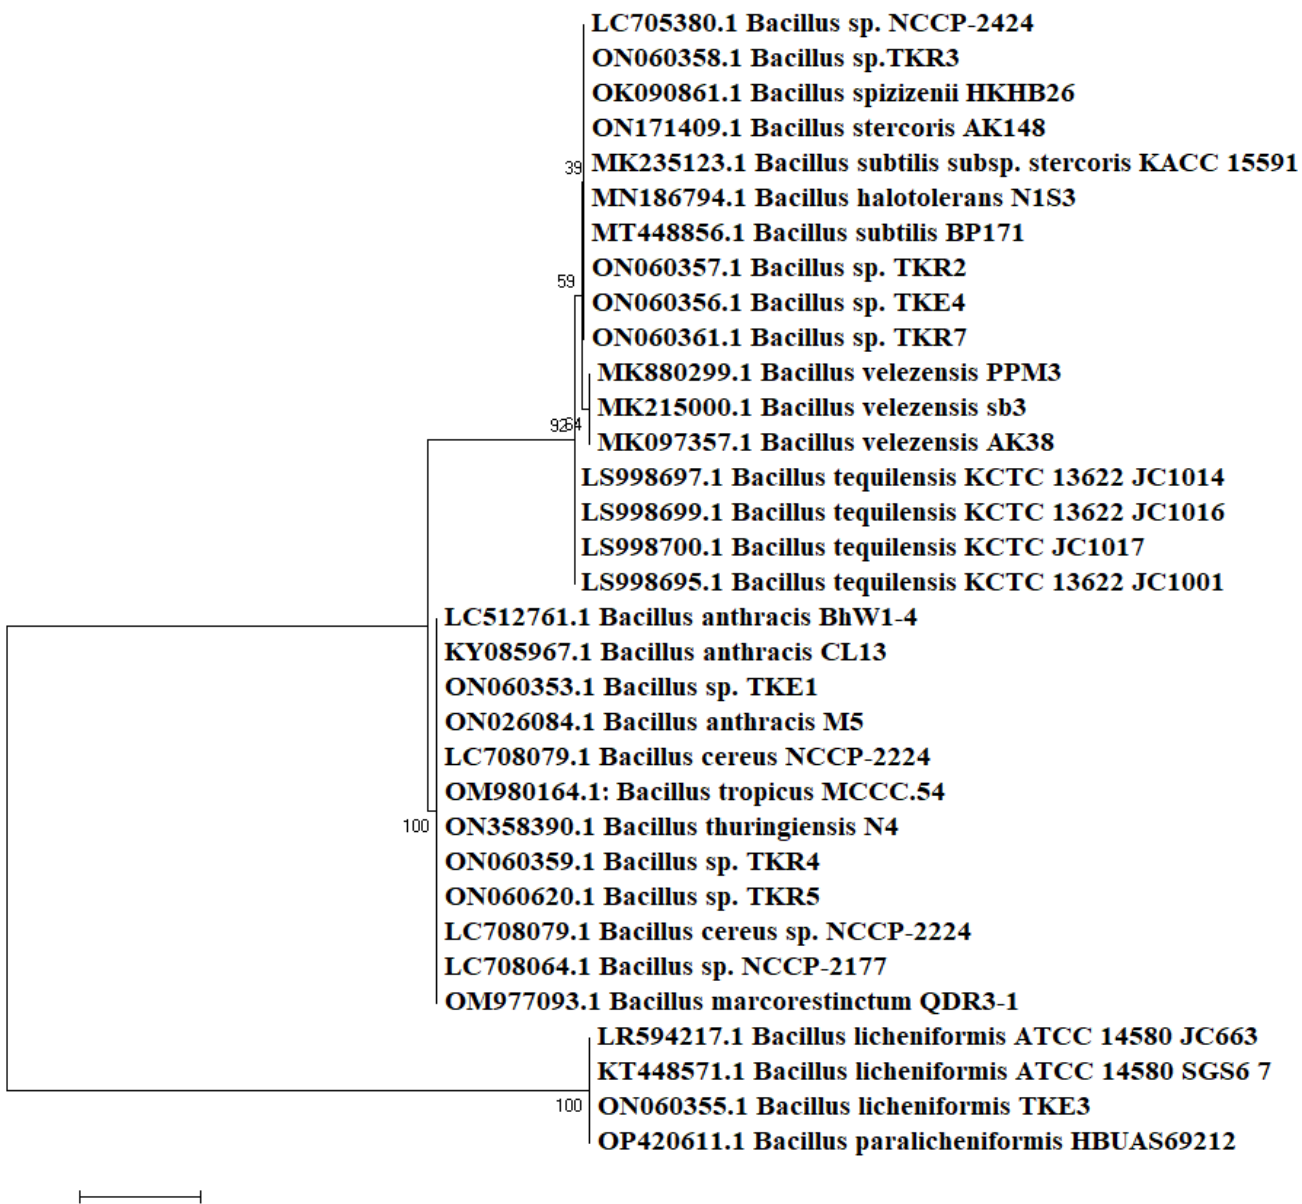
Figure 2. ( A ) Frequency of enzyme production by the isolates on powdered roots of A. macrostachyum as substrate. ( B ) Frequency of enzyme production by the isolates on respective commercial substrates. ( C ) Distribution of bacterial genera among the identified isolates.